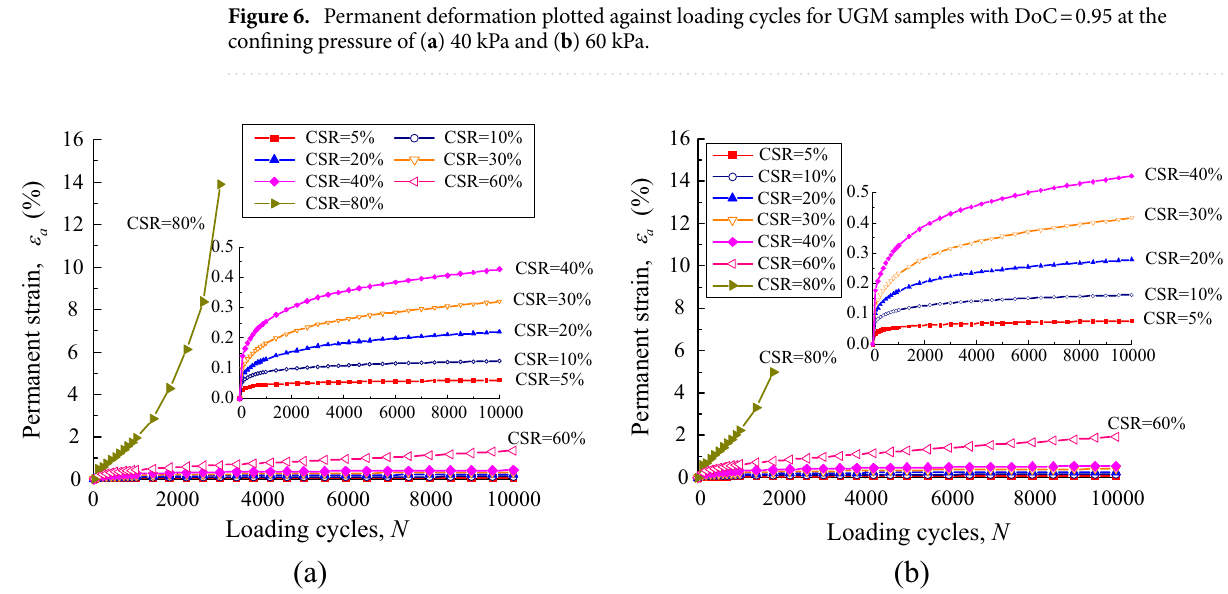
Figure 7. Permanent deformation plotted against loading cycles for gravel samples with DoC = 1.00 at the confining pressure of ( a ) 40 kPa and ( b ) 60